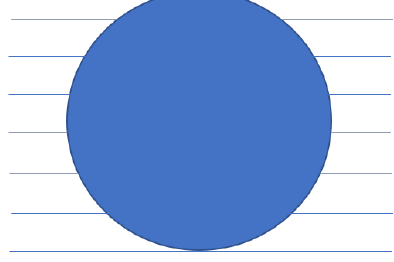
Figure 5. Naive slicing from a facetted model.